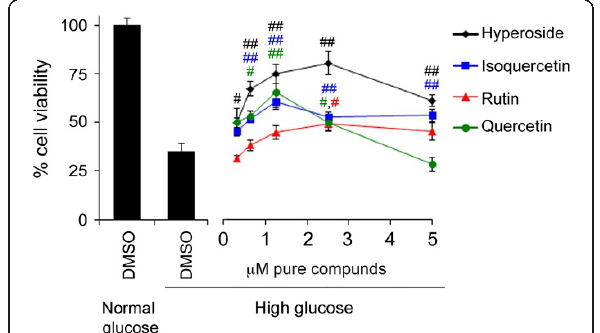
Figure 4 Quercetin and its glycosides protect PC12 cells from high glucose-mediated death. Exposure to glucose toxicity elicited a significant loss in cell viability compared to normal glucose conditions as assessed by mitochondrial dehydrogenase activity measured by cleavage of the formazan dye WST [left panel, ** denotes a significant difference ( p < 0.01) relative to normal glucose control, Student ’ s t -test, n = 16]. Multiple concentrations of quercetin aglycone, hyperoside, isoquercetin (quercetin-3-O- glucoside), and rutin (quercetin-3-O-rutinoside), were administered to high glucose-treated cells to assess cytoprotective activity [right panel, coloured # and ## denote significant differences ( p < 0.05 and ## p < 0.01, respectively) between high glucose control and similarly coloured samples, ANOVA, post-hoc Dunnett ’ s t -test, n = 8-10]. Data are reported as the mean ± SEM.